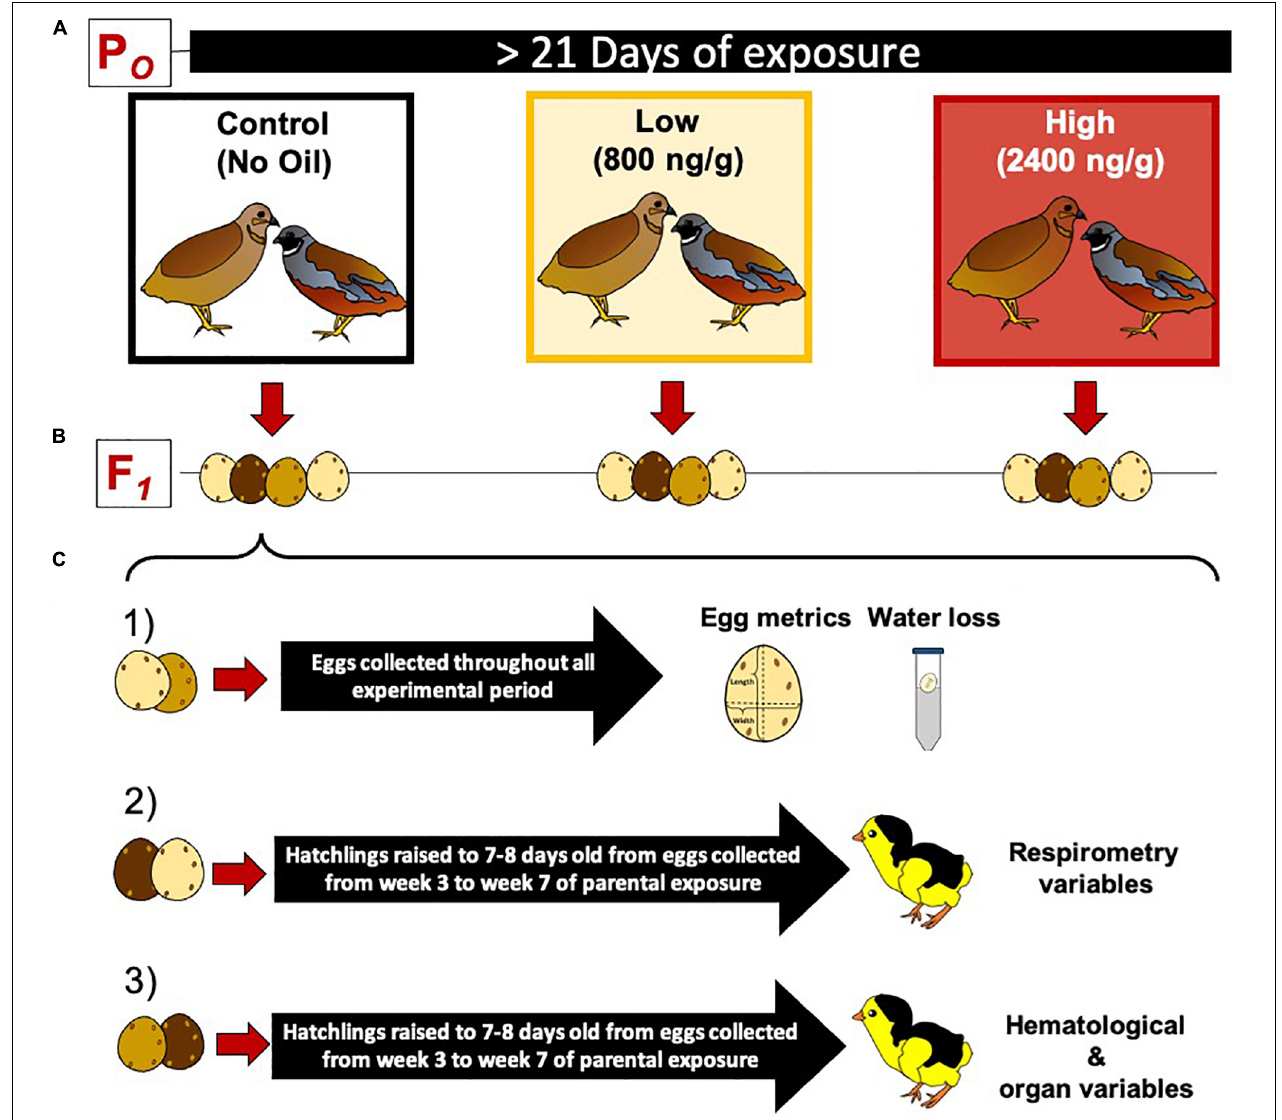
FIGURE 1 | Experimental protocol for dietary crude oil exposure and breeding in the king quail ( Coturnix chinensis ). (A) A parental population of adult birds was divided into three groups (5 female and 5 male per group) and exposed to crude oil via diet for at least 21 days. (B) Adult quail were maintained as female and male couples (monogamous species) and allowed to breed daily. (C) The eggs obtained from each parental group were divided into three subgroups as follows: (1) eggs used to determine egg metrics and water loss, (2) eggs raised to 7–8 day old hatchlings used to measure respirometry variables, and (3) eggs raised to 7–8 days old hatchlings and used to measure blood chemistry, hematology, and organ masses. Eggs used for respirometry and hematological/organ analysis were collected from the third week of exposure toward the end of the experimental